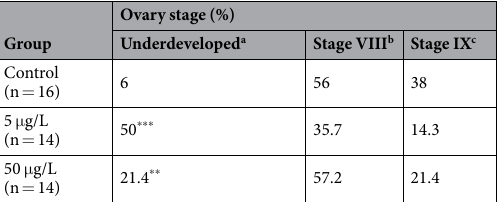
Table 1. Frequency of stages of ovarian development in one week recent metamorphs of H . intermedia . a Underdeveloped ovary were determined by the presence of large areas of proliferation (numerous oogonia and nests of leptotene-pachytene oocytes) and none and/or few early diplotene oocytes. b,c Categorization of ovarian developmental stages following the criteria described by Ogielska and Kotusz 36 . Sample size and frequency are reported. Asterisks indicate statistically significant differences between treatments when compared to the control using the two-tailed Fisher’s exact test ( *** p < 0.001 and ** p < 0.01).